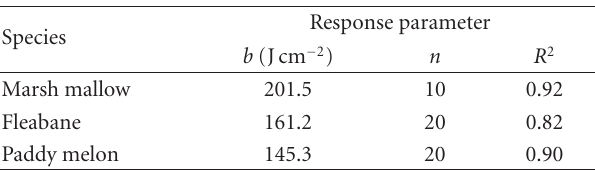
Table 2: Log-logistic dose response parameters for marsh mallow, fleabane and prickly paddy